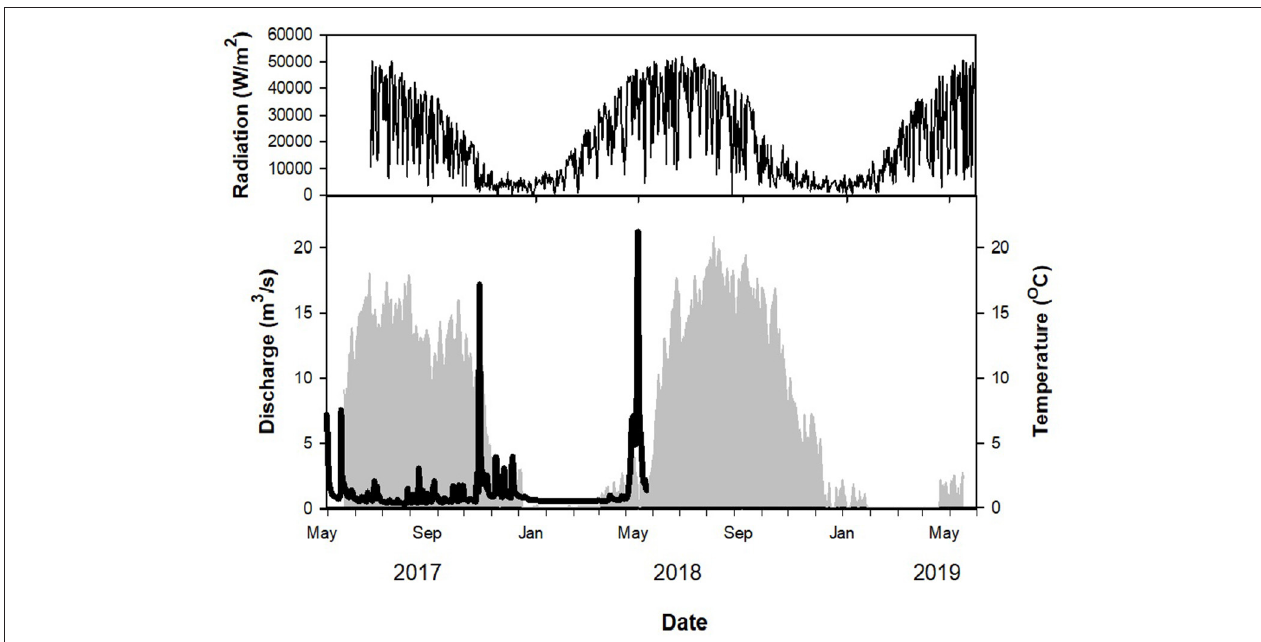
FIGURE 2 | Continuous discharge (thick black line, bottom pane), water temperature (light gray shading, bottom pane) and photosynthetically active radiation (PAR; thin black line, top pane) over course of sampling period. Discharge measurements do not span entire sampling period because the USGS-installed gauge